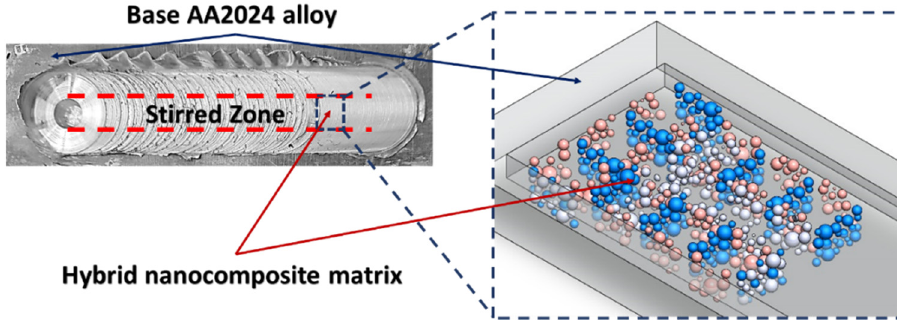
Figure 5: Illustration of the nanoparticle distribution inside the stirred